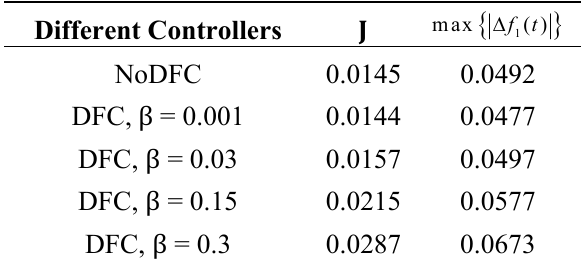
Table 2. Different performances using different controller parameters with the small disturbance ( α =